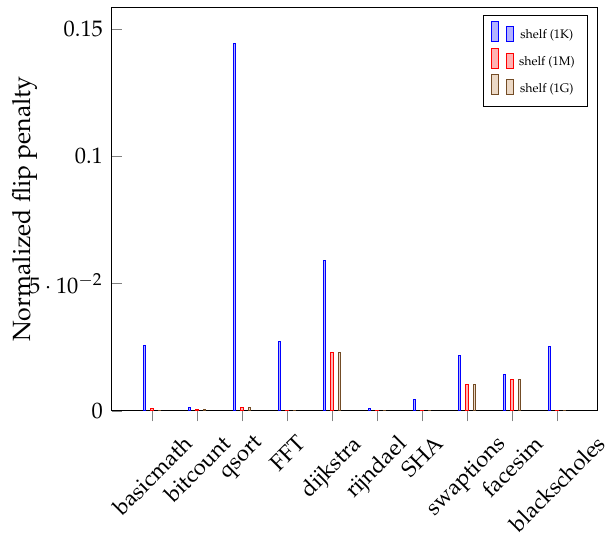
Figure 6. Normalized flip penalty by varying the update